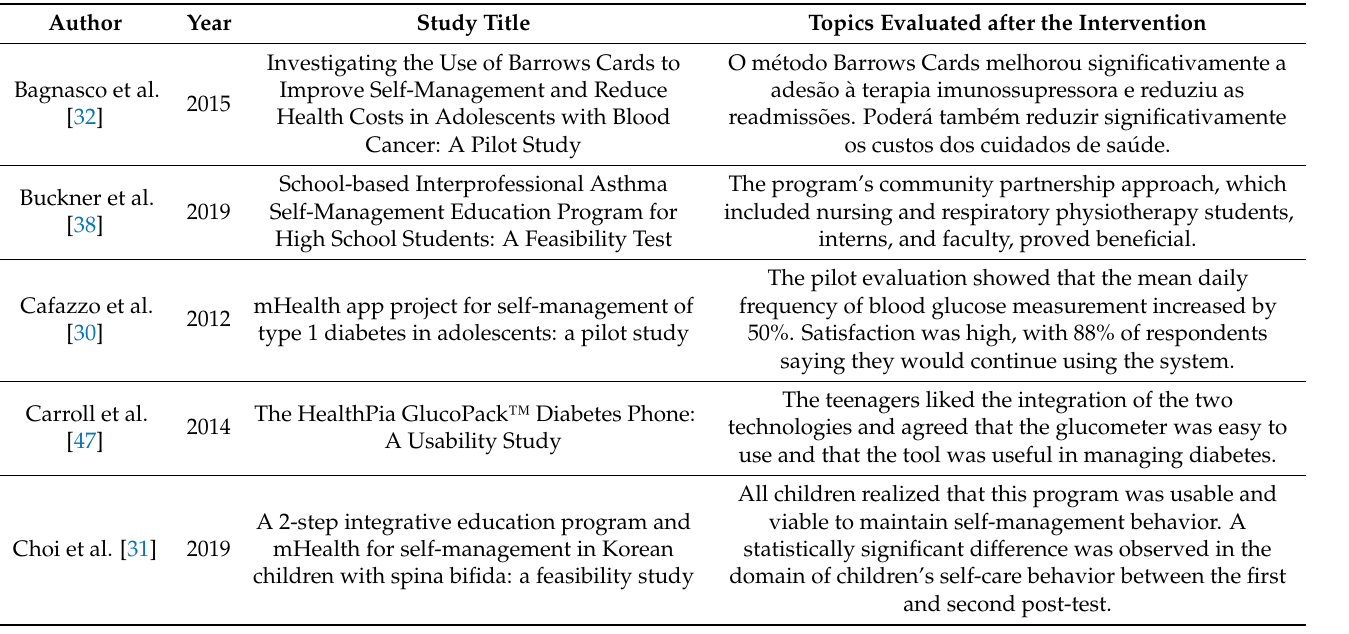
Table A8. The results that were evaluated after the